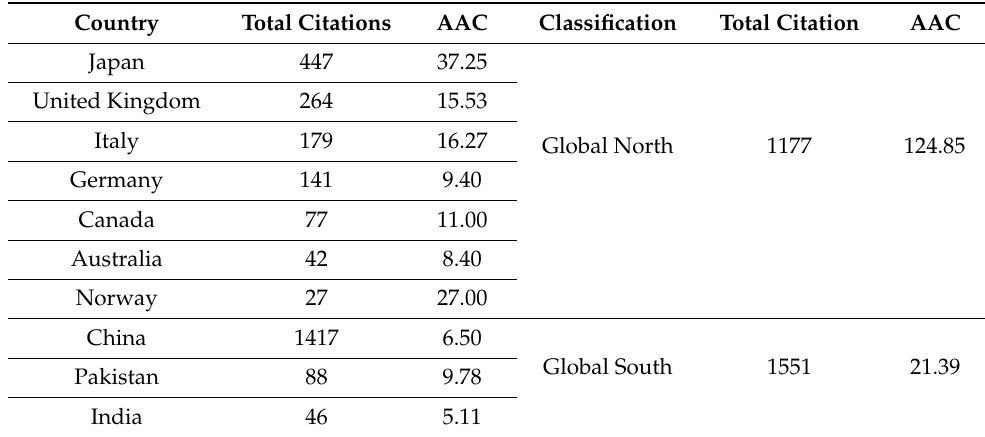
Table 6. Citation based on